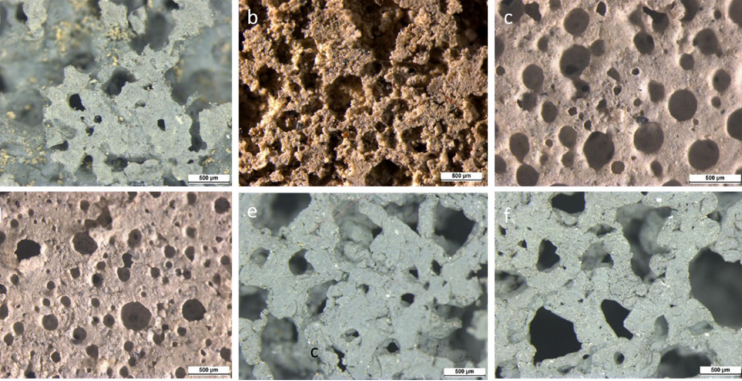
Figure 4. Optical microscopy images of samples sythetized with silica fume: sample 1 ( a ), 5 ( e ) and